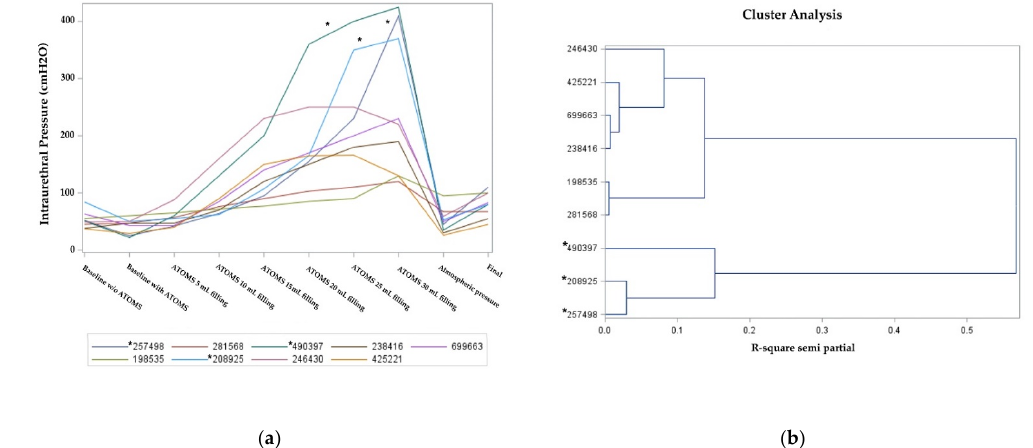
Figure 4. Intraurethral pressure for different cushion volume: ( a ) Stress test performed for each patient, expressed as ID number; ( b ) cluster analysis distinguishes two different patterns of intraurethral pressure. Patients in cluster 2 are marked with asterisks. Table 2. Cluster characterization according to features expressed; significant values in bold.